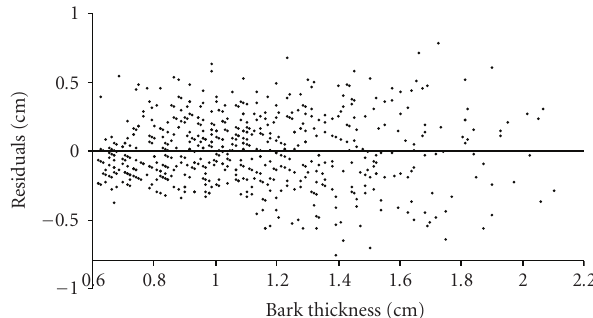
Figure 2: Residual plot of the Alaska bark thickness model.